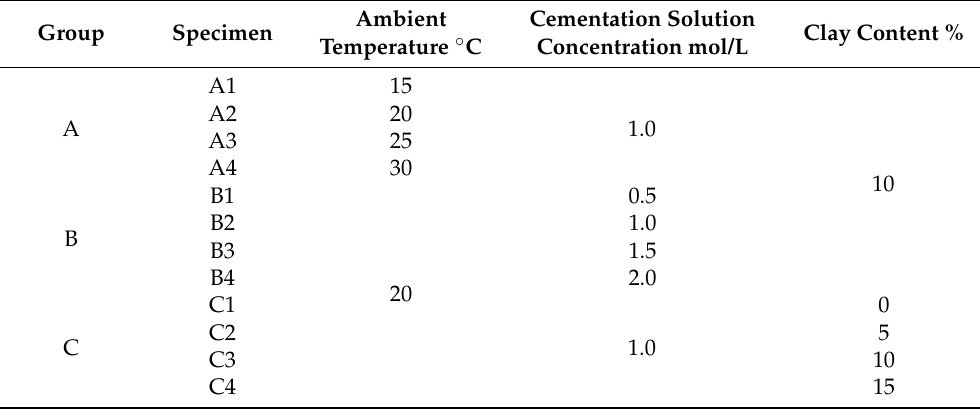
Figure 5. Sample preparation and testing. ( a ) Solution preparation, ( b ) Sample preparation, ( c ) Test. Table 2. Specimen grouting and preparation.